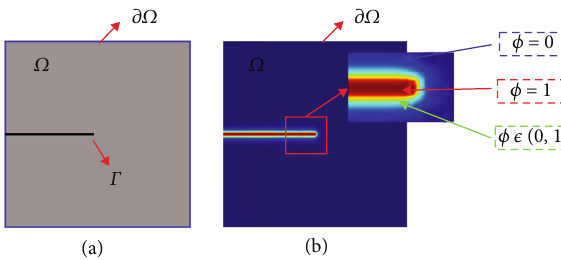
Figure 1: Schematic diagram of cracks. (a) Sharp crack. (b) Phase fi eld discrete